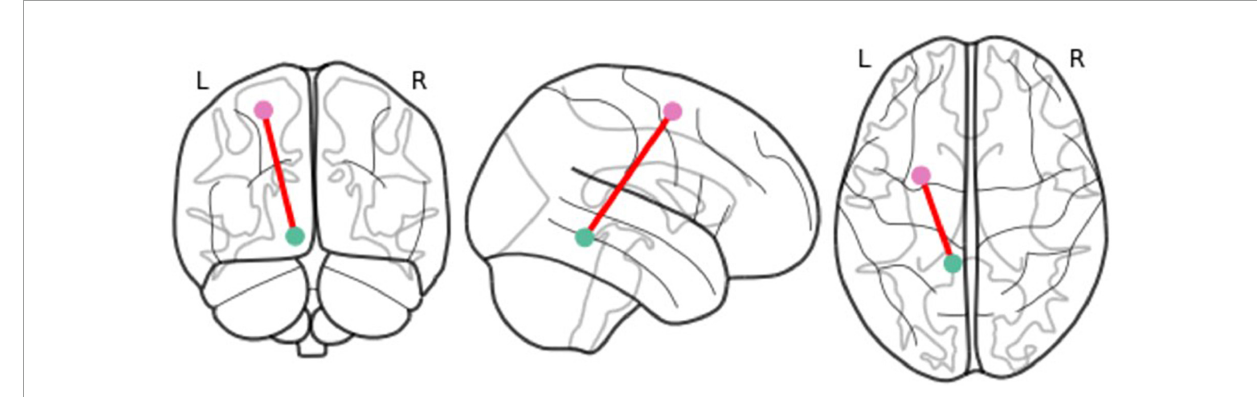
FIGURE3 Visualization of the coupling which significantly mediated the relationship between peer victimization and lagged within-person internalizing symptoms: Amygdala-ventral posterior insula resting-state functional connectivity.